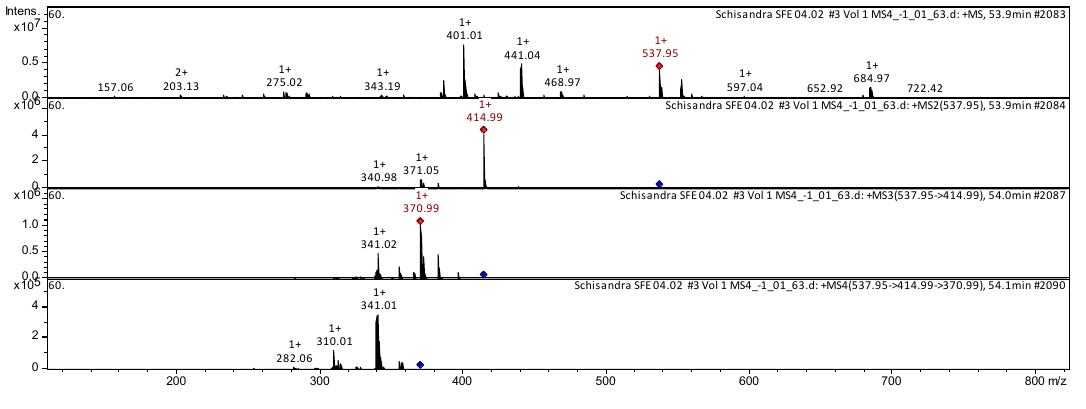
Figure 4. CID spectrum of the schisantherin A (gomisin C) from S. chinensis , m/z 537.95.